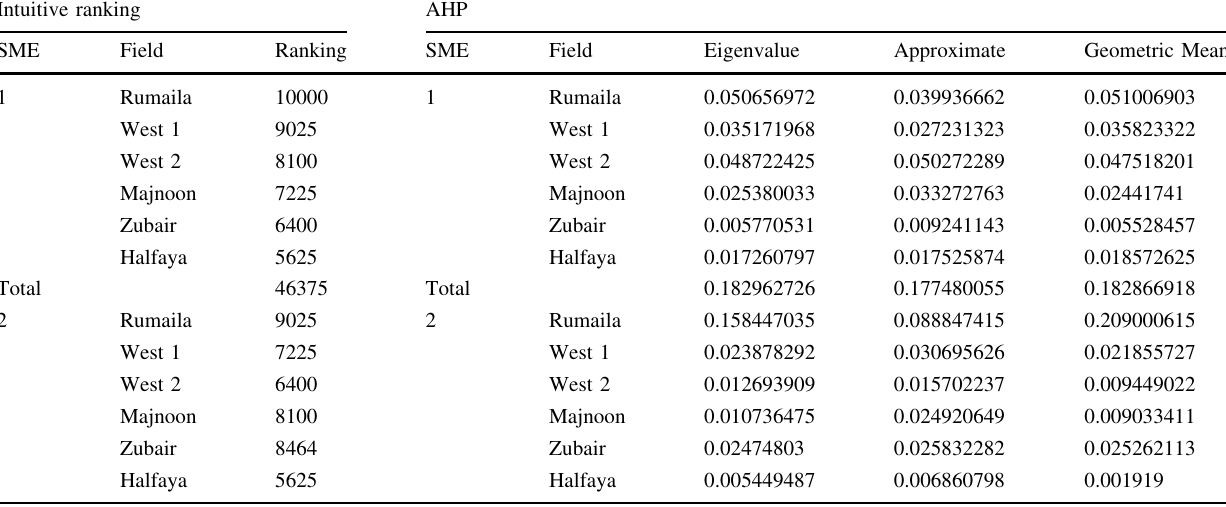
Table 15 Organized ranking results Intuitive